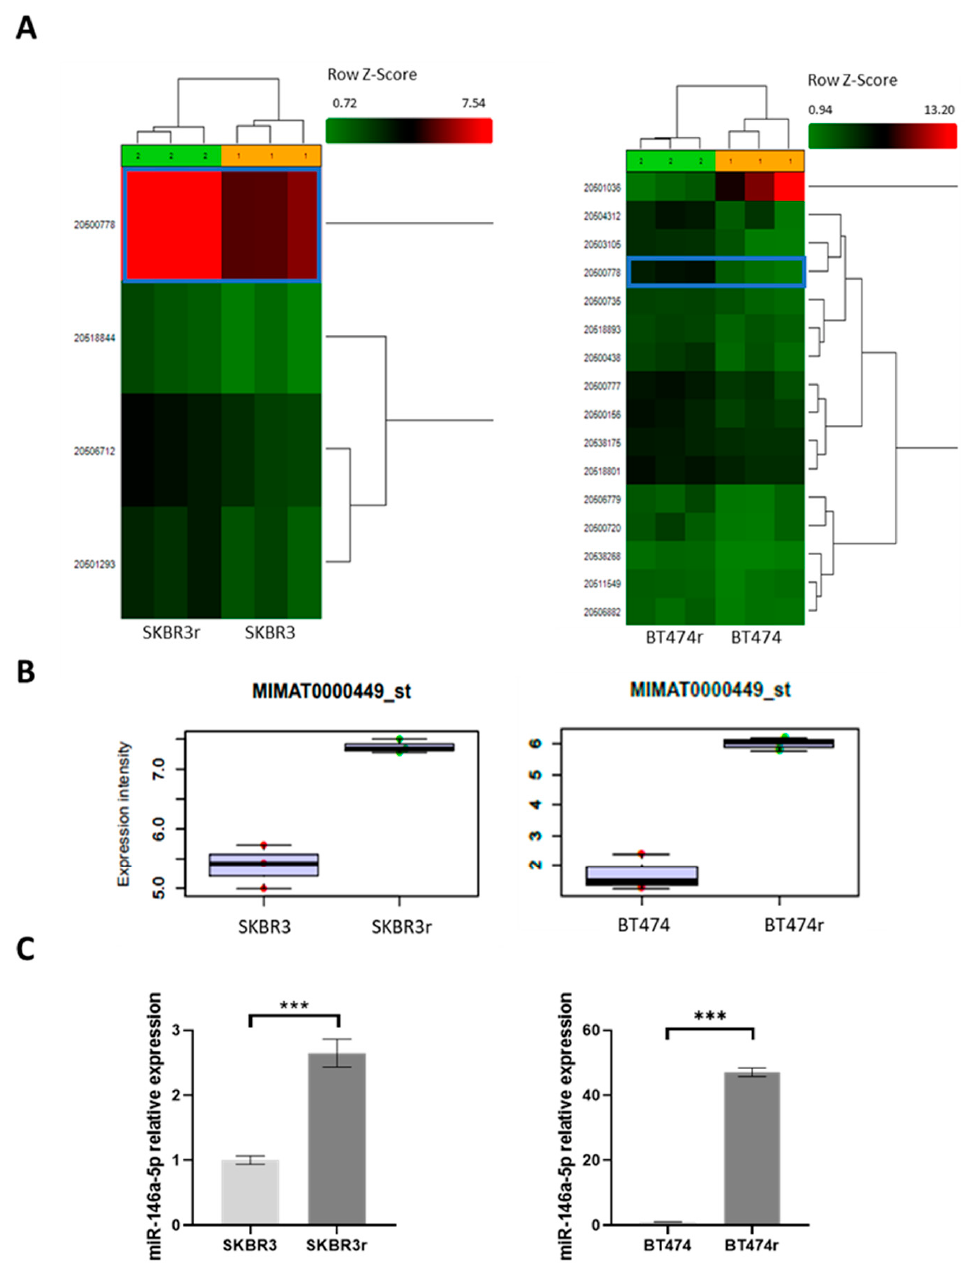
Figure 1. miRNA differential expression between parental and trastuzumab-resistant cell lines. ( A ) The heat map shows significant differences in miRNA expression between SKBR3/SKBR3r and BT474/BT474r analyzed via the Affimetrix human miRNA microarray GeneChip miRNA 4.0 Array, and their hierarchical clustering. miR-146a-5p expression is highlighted with a box. Three repeated samples were used for each cell type. ( B ) Expression intensity of miR-146a-5p (MIMAT0000449_st) in SKBR3/SKBR3r and BT474/BT474r samples of the GeneChip miRNA 4.0 Array of the A ff ymetrix microarray. ( C ) Expression levels of miR-146a-5p in cells were measured via RT-qPCR for validation. GAPDH was used as an endogenous control. RT-qPCR was performed in technical and biological triplicates. *** p -value < 0.001. 3.2. High Expression of miR-146a-5p Associated with Relapse and Shorter Disease-Free Survival in HER2+ BC Patients To test the hypothesis of the potential association of miR-146a-5p overexpression with resistance to trastuzumab, its expression was analyzed in a cohort of HER2+ BC patients’ samples from the Hospital Clínico de Valencia. Patients who relapsed after the trastuzumab-containing miR-146a-5p expression compared to patients who remained disease-free after therapy ( p = 0.040) (Figure 2A). Kaplan-Meier curves were also assessed to analyze their prognostic value, and the results showed a signi fi cantly shorter disease-free survival (DFS) in HER2+ BC